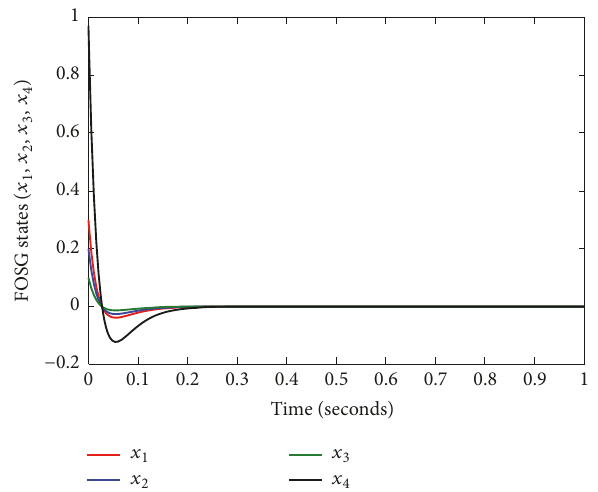
Figure 12: Time history of GAFOPID controlled FOSG system states.